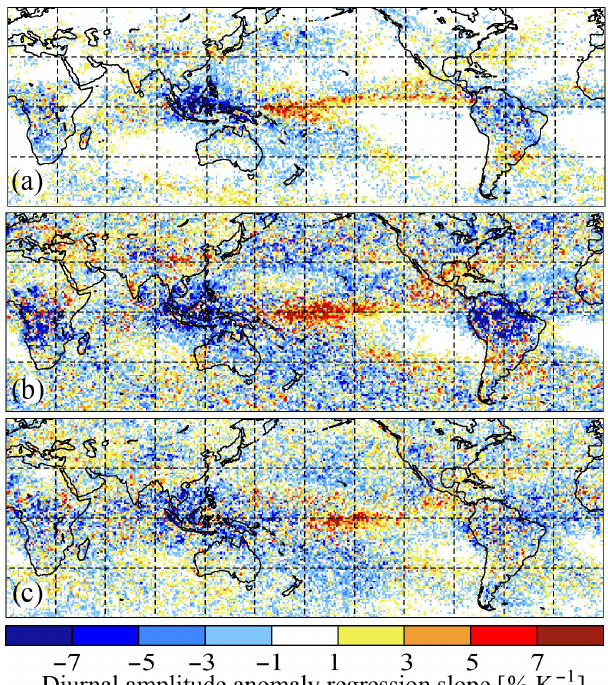
Figure 10. Geographical maps of linear regression slopes between de-seasonalized monthly mean diurnal amplitude anomalies from combined AIRS-CIRS and IASI-CIRS cloud data and global mean T surf anomalies from ERA-Interim for (a) high opaque cloud cov- erage, (b) cirrus, and (c) thin